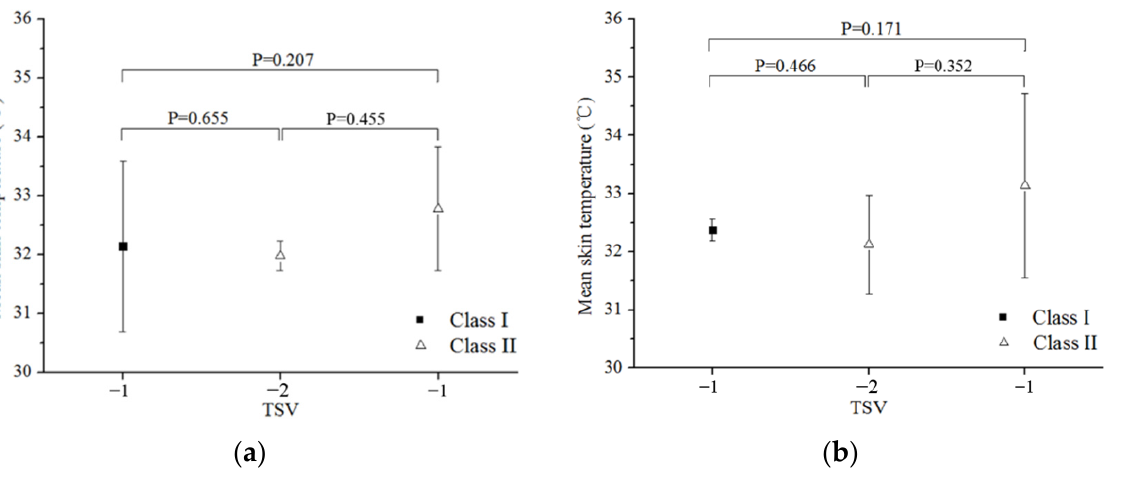
Figure 11. Interval plot of mean skin temperature by thermal sensation of Class I and Class II in scenario C and D. (( a ): scenario C, 29 → 23 °C, ( b ): scenario D, 27 → 23 °C). Vertical bars represent 95% confidence intervals (CI) for the mean.